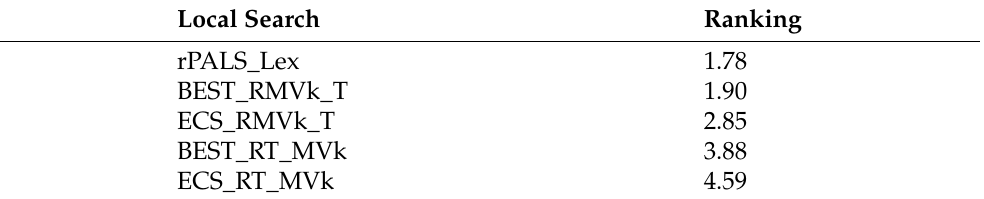
Table 15. Energy Friedman ranking on the 400 scheduling problems (b-level).